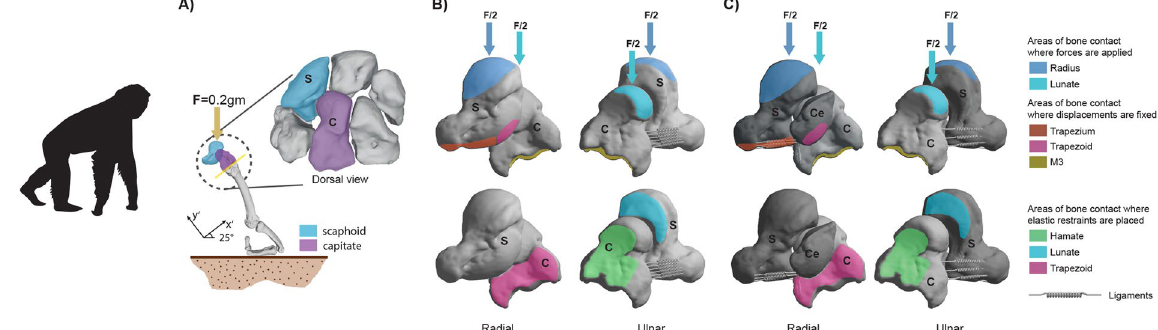
Figure 1. Biomechanical problem under analysis displayed using the bones from the left limb of a Pan troglodytes specimen (S: scaphoid; C: capitate; Ce: centrale. ( A ) Depicts the position of the bones under analysis during a standing scenario, ( B ) shows a fused model and ( C ) displays a non-fused model (i.e., the scaphoid and centrale are simulated as separated bones). Please note that view of the carpal bones was defined according to the human anatomical standard position.